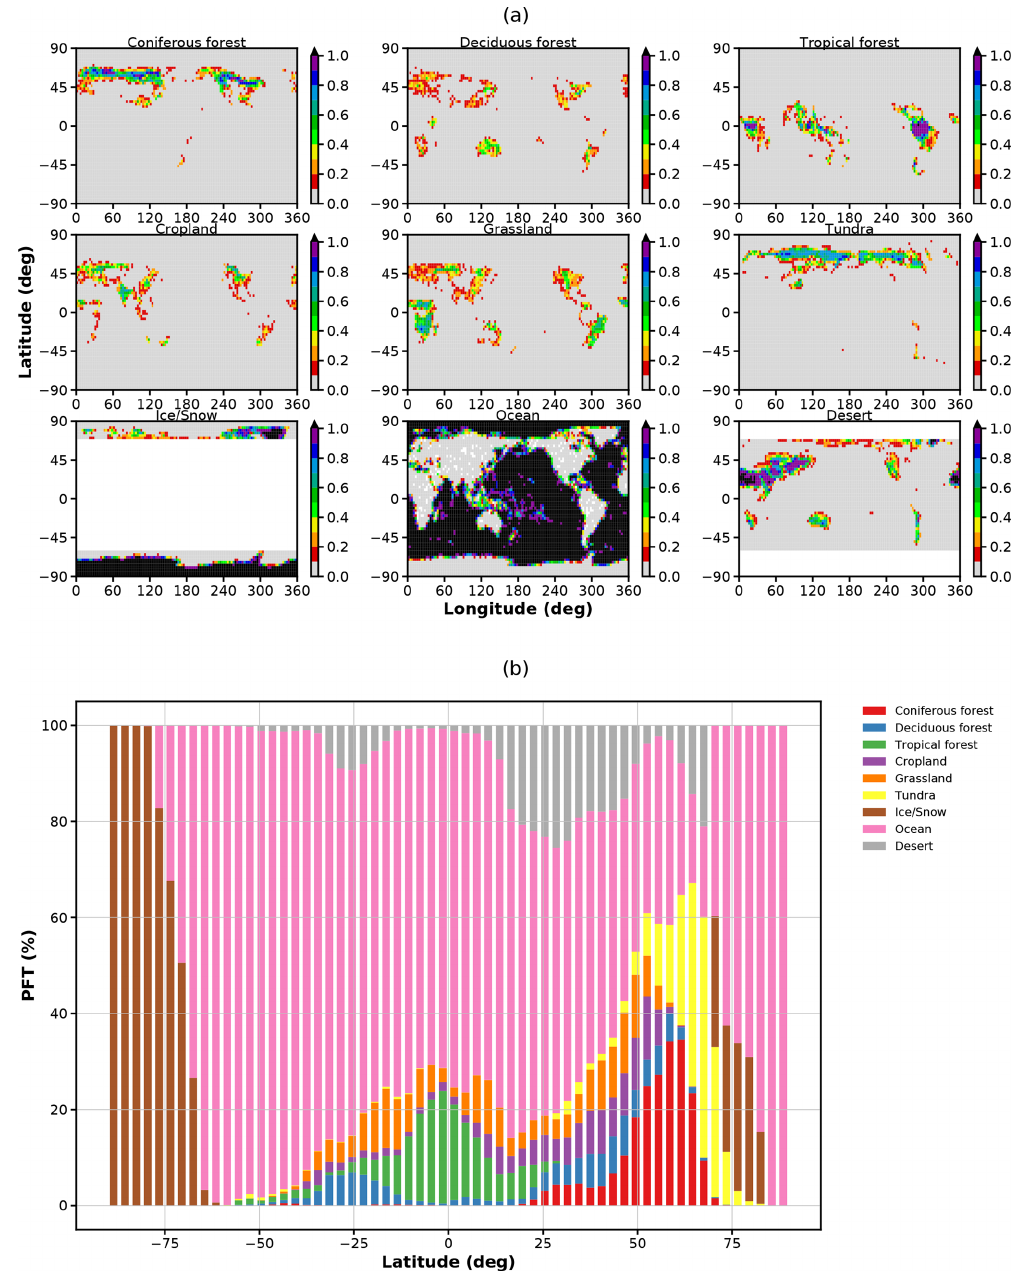
Figure A2. Partitioning of land surface types: (a) CLM 2 dynamic land surface types in 0 . 5 ◦ × 0 . 5 ◦ resolution; (b) zonal distribution of land surface